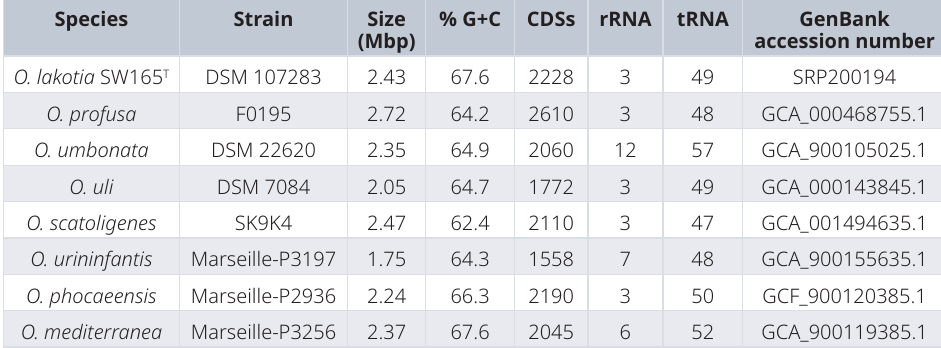
Table 3. General genome characteristic of O. lakotia SW165 T and its